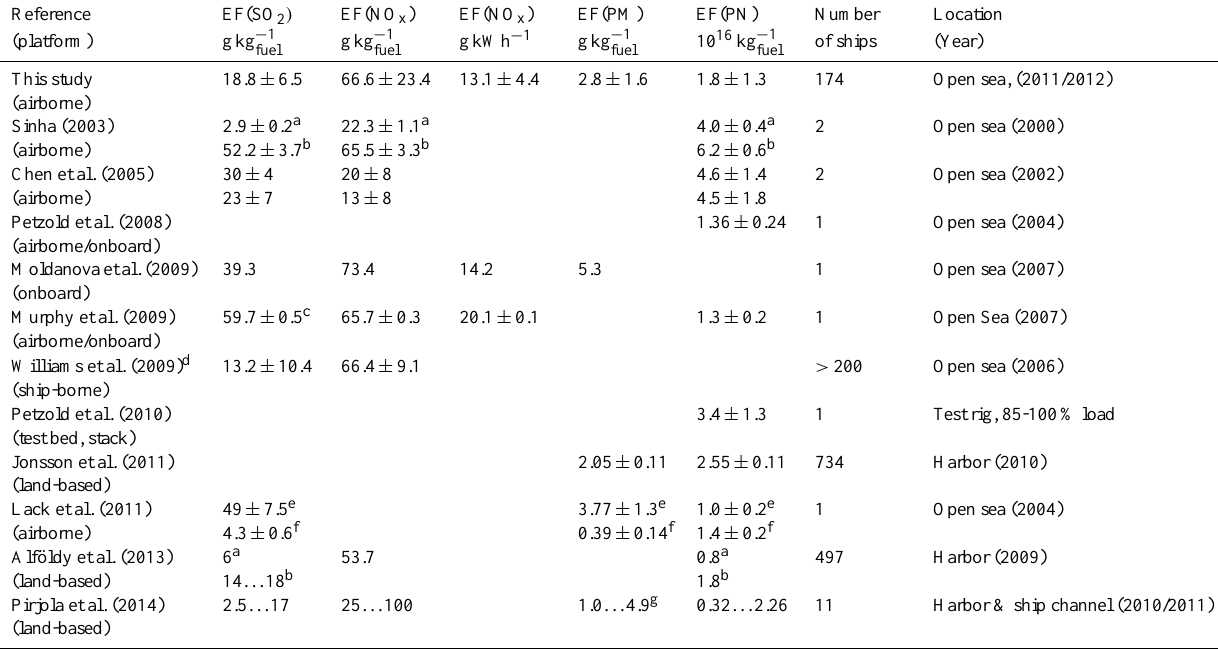
Table 6. Comparison of the emission factors found in this study with the